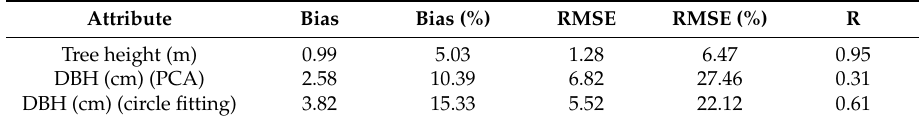
Table 5. Accuracy of tree attribute estimation based on direct measurements from the point